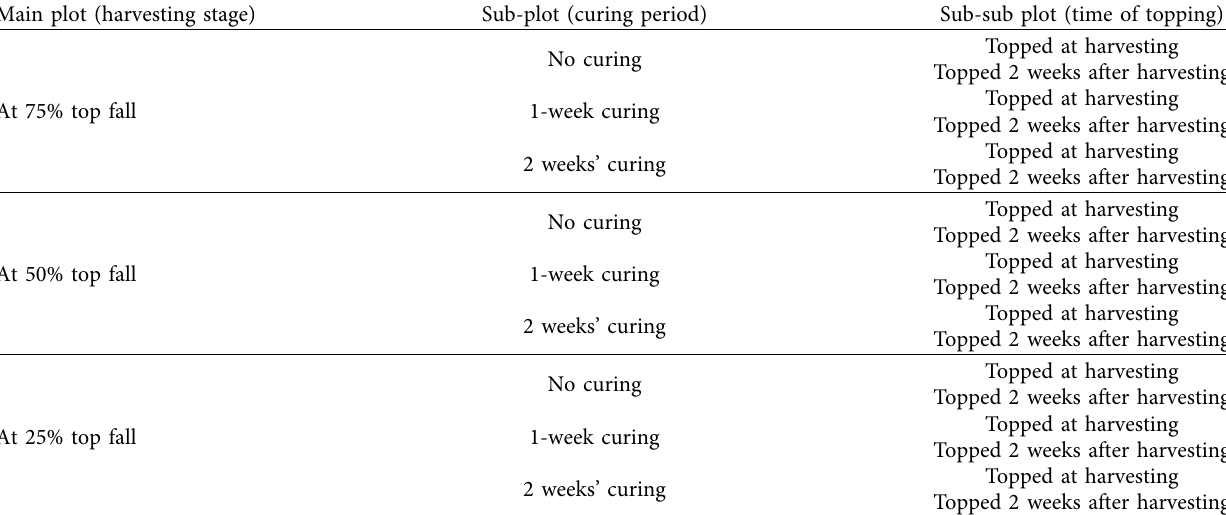
Table 1: Treatment